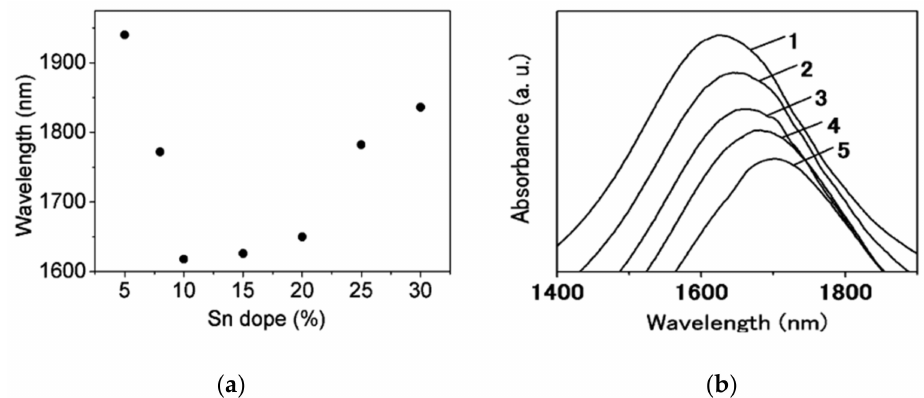
Figure 17. ( a ) Dependence of the plasmonic resonance of ITO/Sn alloyed NPs for different Sn concentrations. ( b ) RI sensitivity for the 8% Sn concentration NP. Curves 1 to 5 represent the following RI values: 1.37, 1.42, 1.48, 1.55 and 1.55. Reproduced with permission from